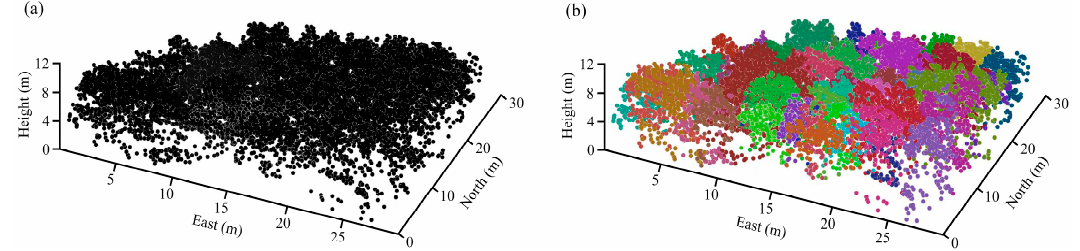
Figure 3. ( a ) Point cloud of one plot; and ( b ) the result of segmentation using PCS algorithm (each single tree corresponds to a color).